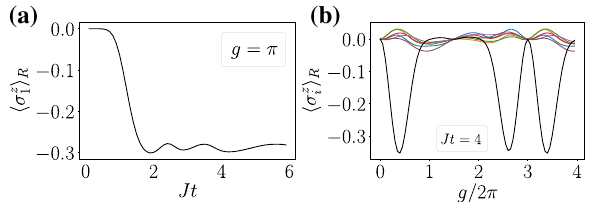
Fig. 9 Illustration of teleportation protocol in Hamiltonian 37: a For an input state at qubit 1 on the left, such that (cid:12) σ z for g = π the expectation value on the right at qubit 1 is presented. b For a time Jt = 4, we present (cid:12) σ z qubit. The teleportation succeeds at qubit 1, shown in black color, while at all other qubits, (cid:12) σ i (cid:19)= 1 (cid:7) R ≈ 0